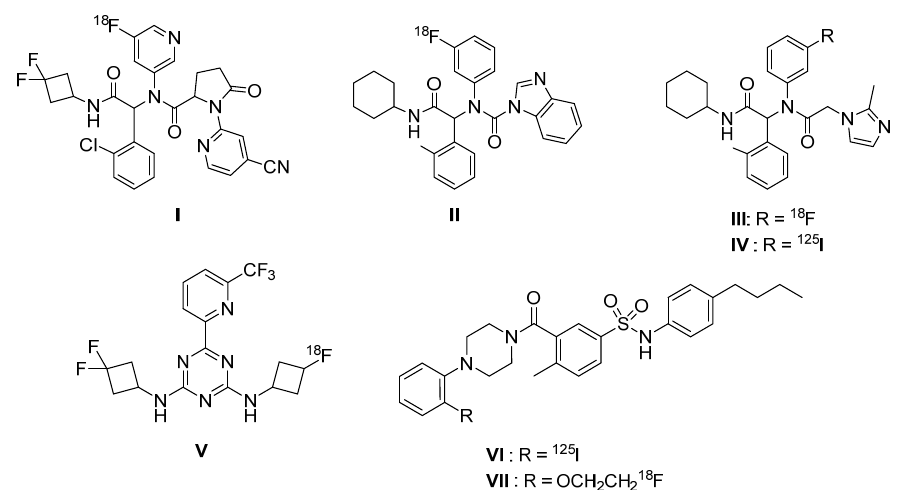
Figure 1. Structures of known mIDH1 targeting radiotracers.